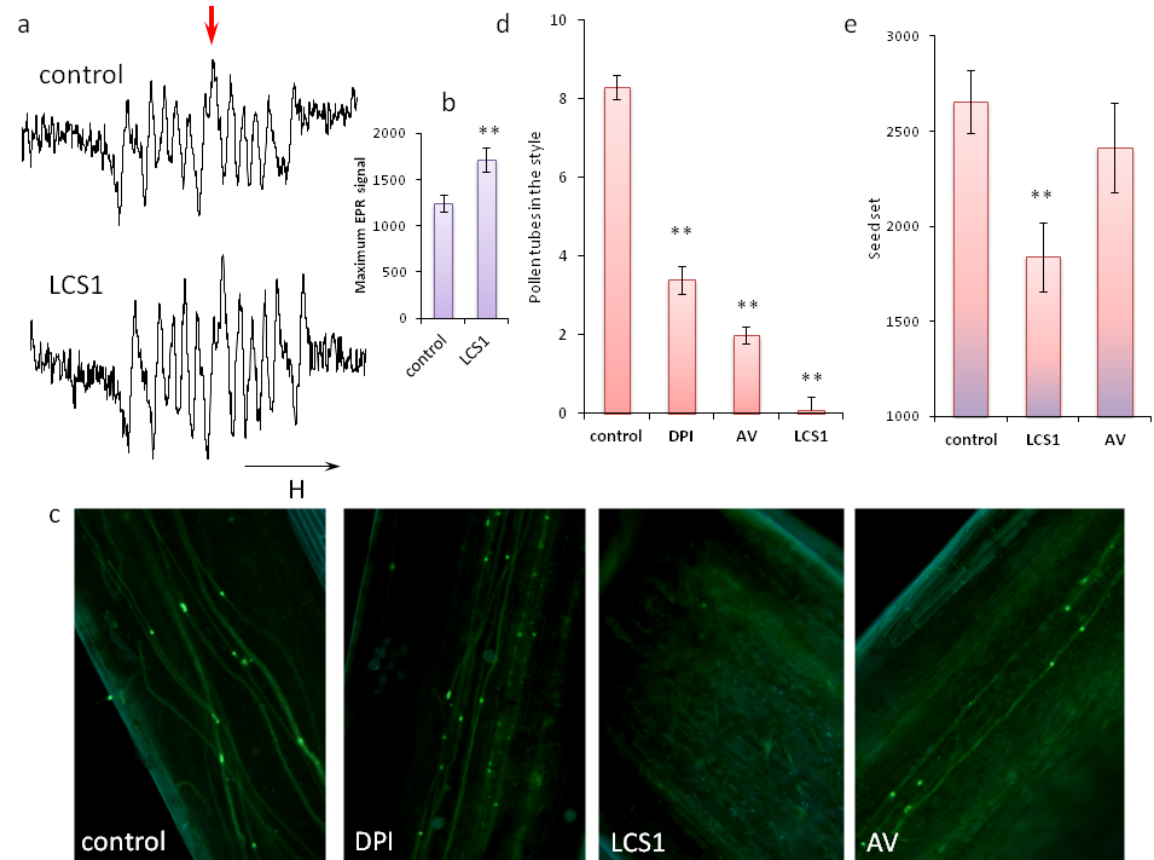
Figure 3. Significance of ROS balance for the rate and efficiency of pollen germination in vivo . ( a ) Typical EPR signals of stigma exudate from control and LCS1-treated flower; ( b ) averaged values of EPR signals (the second peak, indicated by an arrow in ( a ), n = 6); ( c ) typical fluorescent pictures of styles 30 min after pollination (AP), pollen tube wall is stained by decolorized aniline blue, magnification 100 × , DPI (diphenyleneiodonium chloride) and AV (acetovanillone): inhibitors of NADPH oxidase, LCS1: inhibitor of Cu/Zn SOD; ( d ) average number of pollen tubes in a pistil style 30 min AP; ( e ) seed set (an average number of seeds in a capsule) 4 weeks AP. Asterisks indicate a significant difference between the means (**- p <0,01).